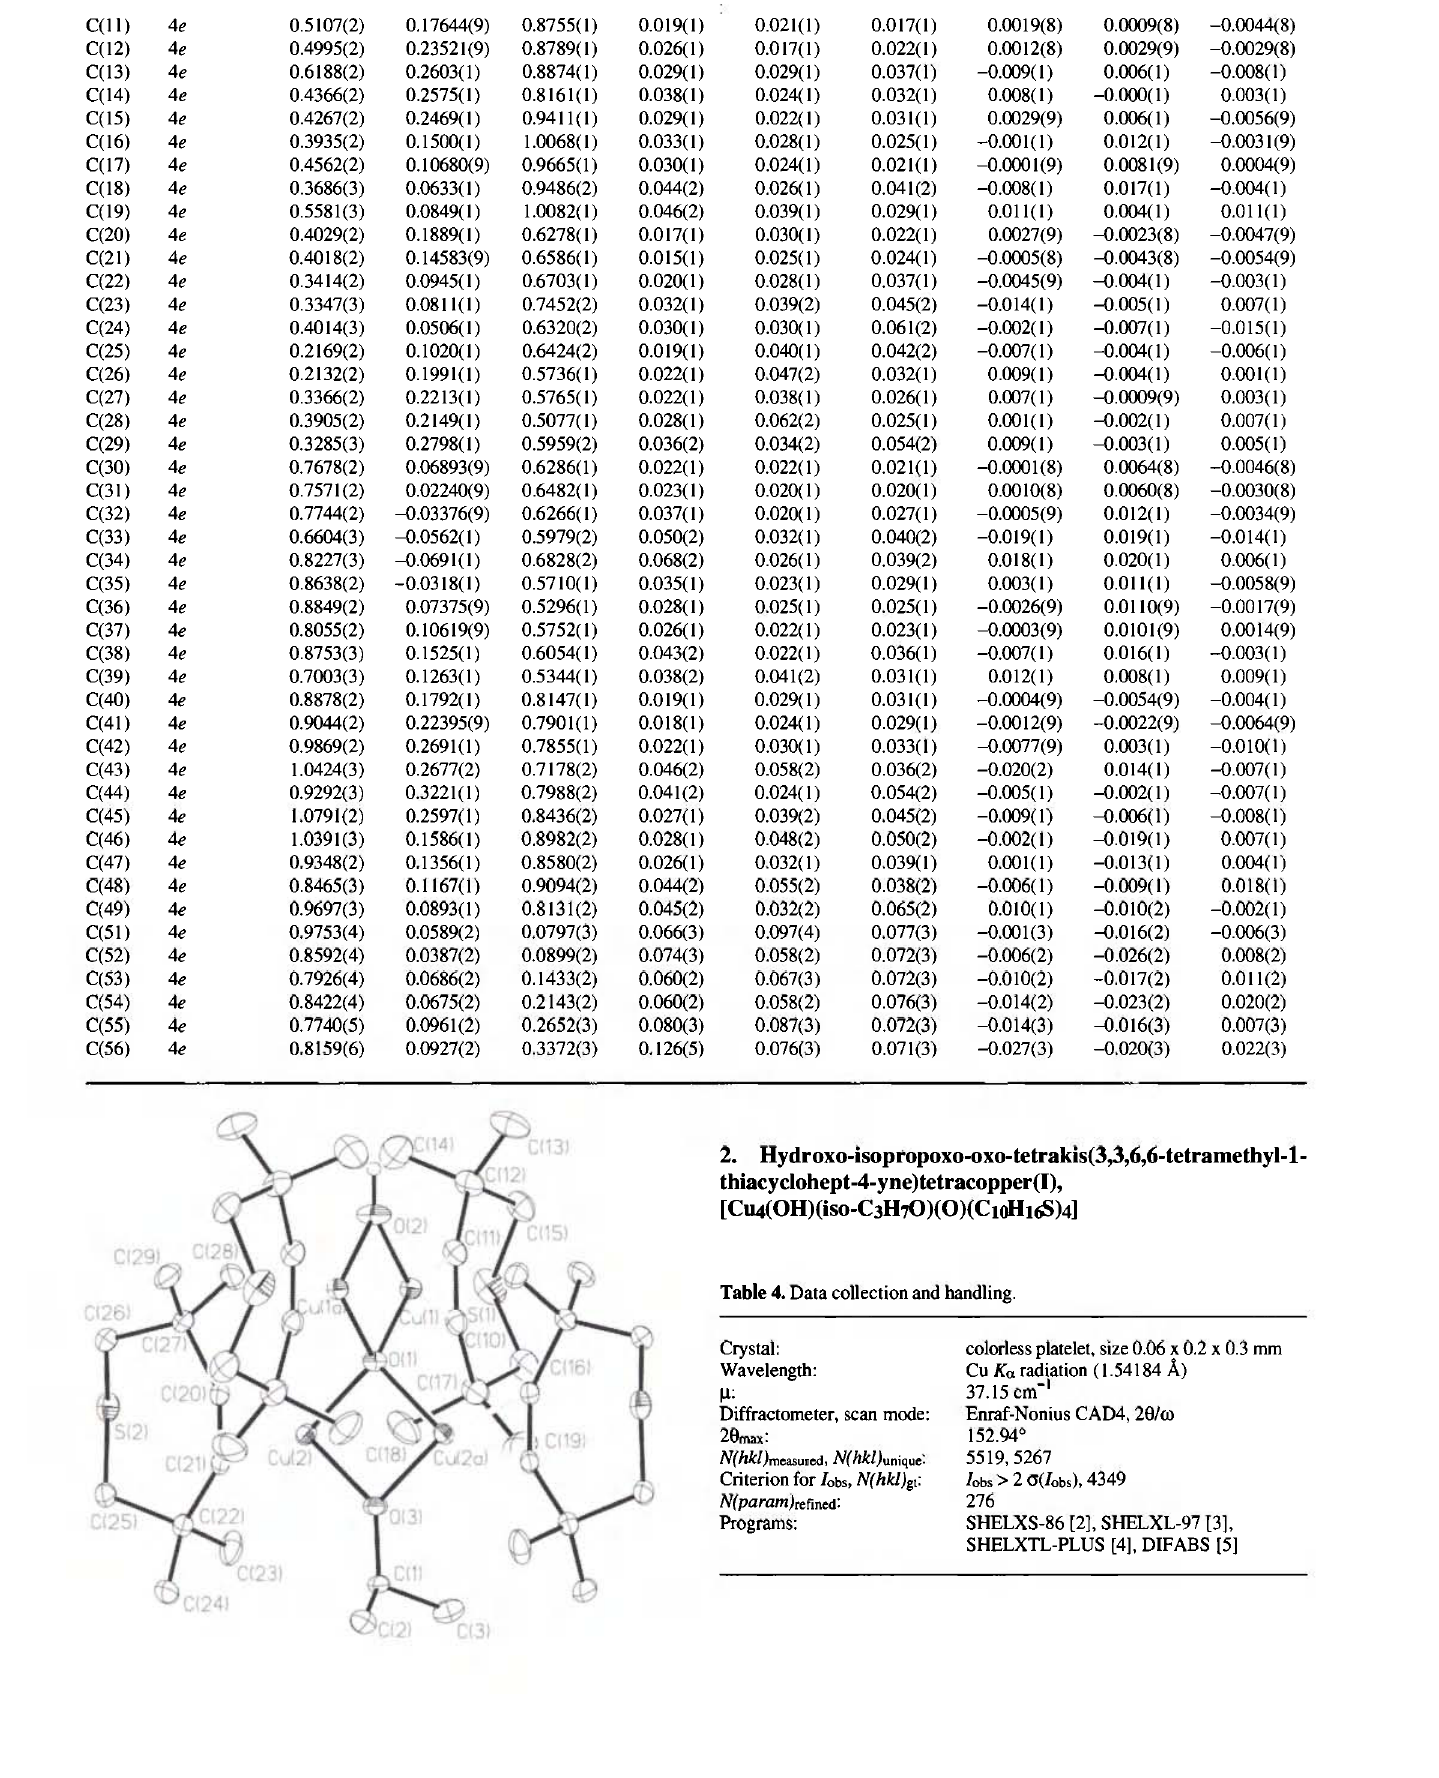
Table 4. Data collection and